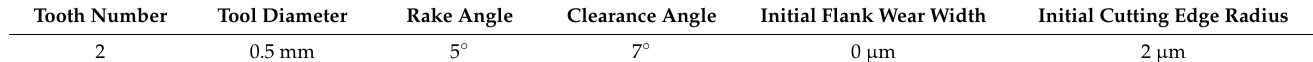
Table 3. Parameters of the micro-milling tool.